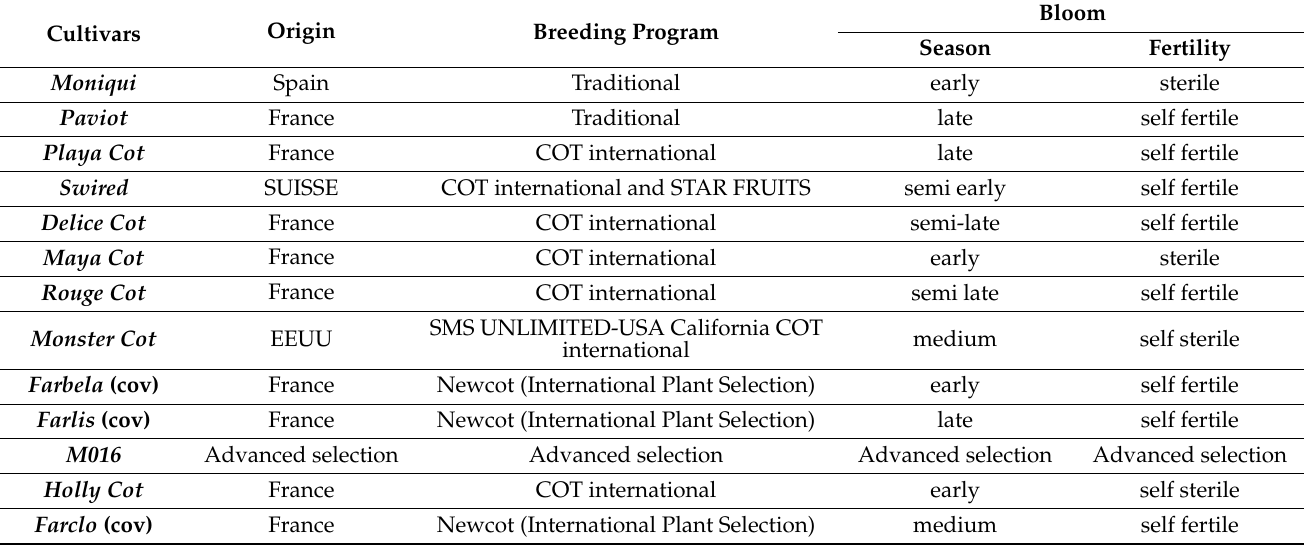
Table 1. Origin, breeding program, and bloom characteristics of the 13 cultivars used in this study. Cultivars Origin Breeding Program